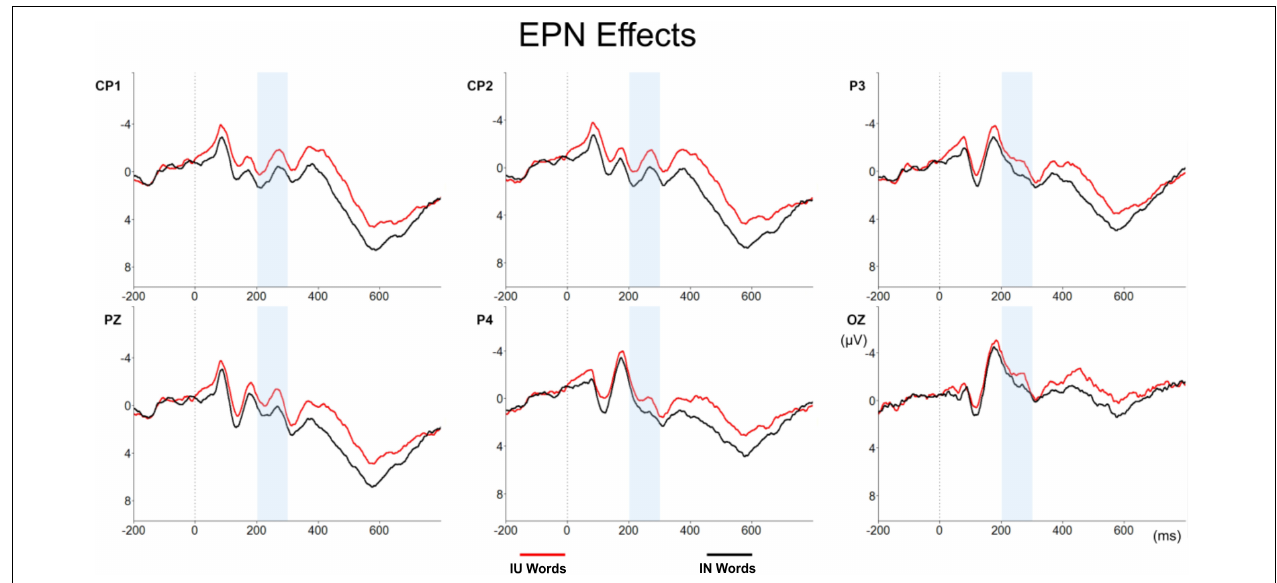
FIGURE 1 | EPN effect. EPN amplitudes for the IU (red line) and the IN words (black line). The time range of the EPN component is indicated by a blue